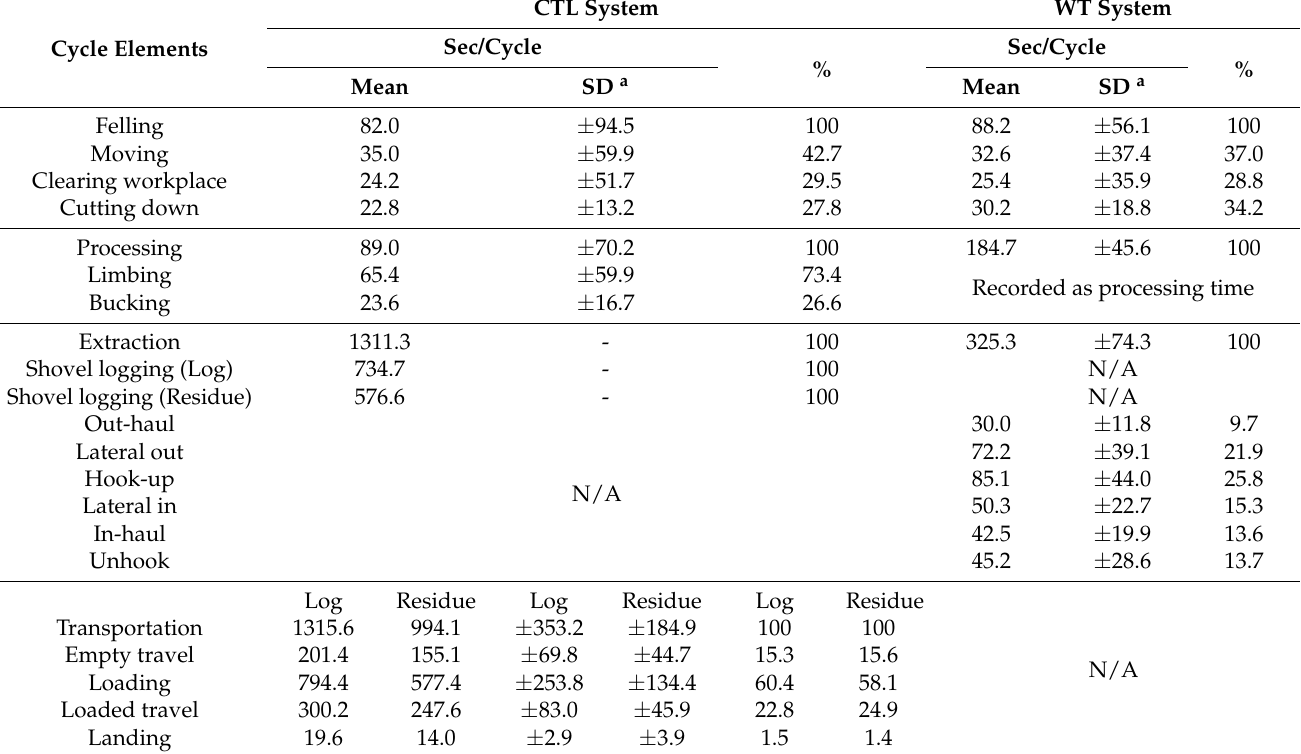
Table 5. Mean cycle time at each operational activity in both CTL and